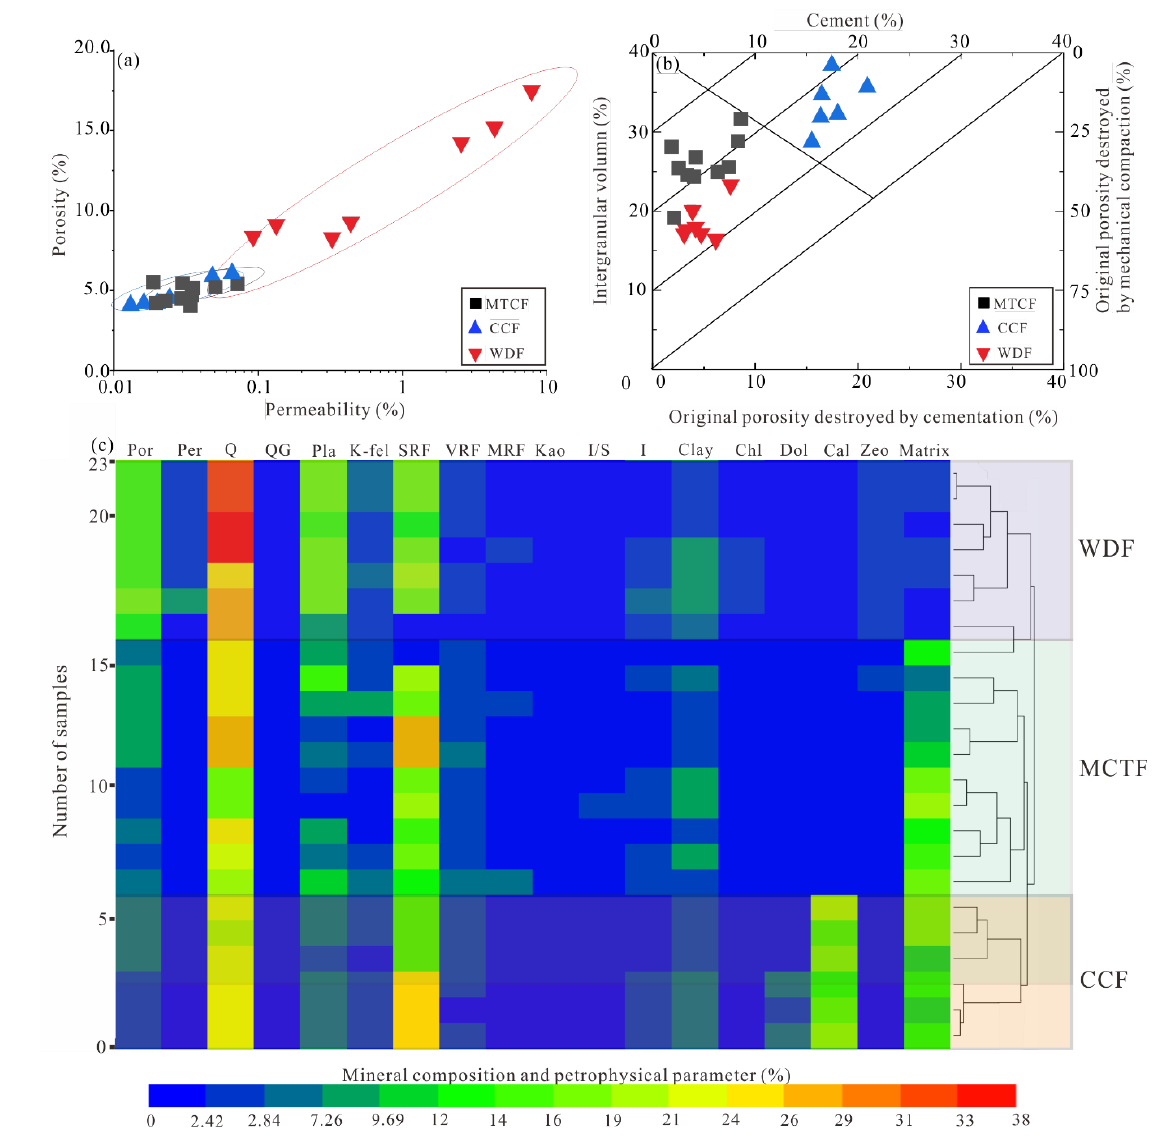
Figure 3. Petrophysical parameters, the original porosity destroyed by cementation and mechanical compaction, and mineral characteristics of three sandstone facies developed in the Toutunhe Formation: ( a ) Relation of porosity and permeability, ( b ) Plot of cement volume versus intergranular volume in Toutunhe sandstones, ( c ) The heat map of mineral composition and petrophysical parameters. Q, quartz; QG, quartz overgrowth; Pla, plagioclase; K-fel, potassium feldspar; MRF, metamorphic rock fragment; VRF, volcanic rock fragment; SRF, sedimentary rock fragment; Cal, calcite; Sid, siderite; Chl, chlorite; I, illite; Kao, kaolinite; Sid, siderite; I/S illite-smectite mixed layer; Zeo: zeolite.